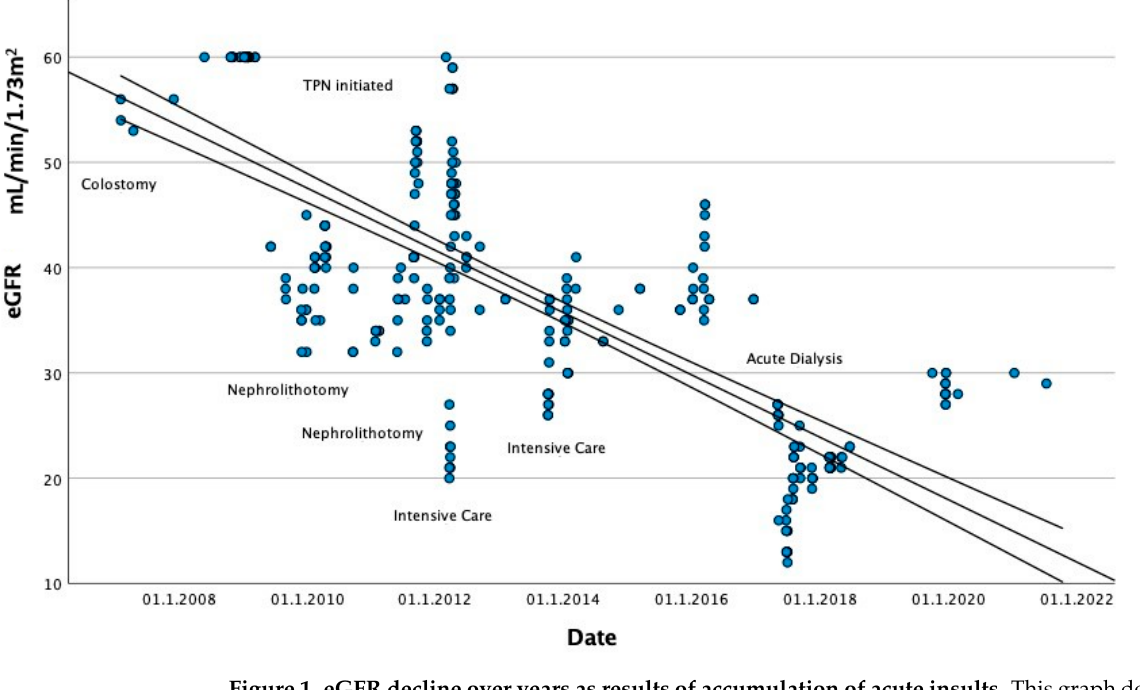
Figure 1. eGFR decline over years as results of accumulation of acute insults. This graph describes the downtrend of calculated glomerular filtration over time. The time line has been divided base on acute events to highlight the impact of specific illness or medical intervention on the subject’s renal function. It is clear that not only uropathy associated to stone disease contributed to the reduction in estimated glomerular filtration rate (eGFR) but also severe illness requiring intensive care admission and organ support had significant impact. The graph illustrates the effect of cumulative insults to the renal function.